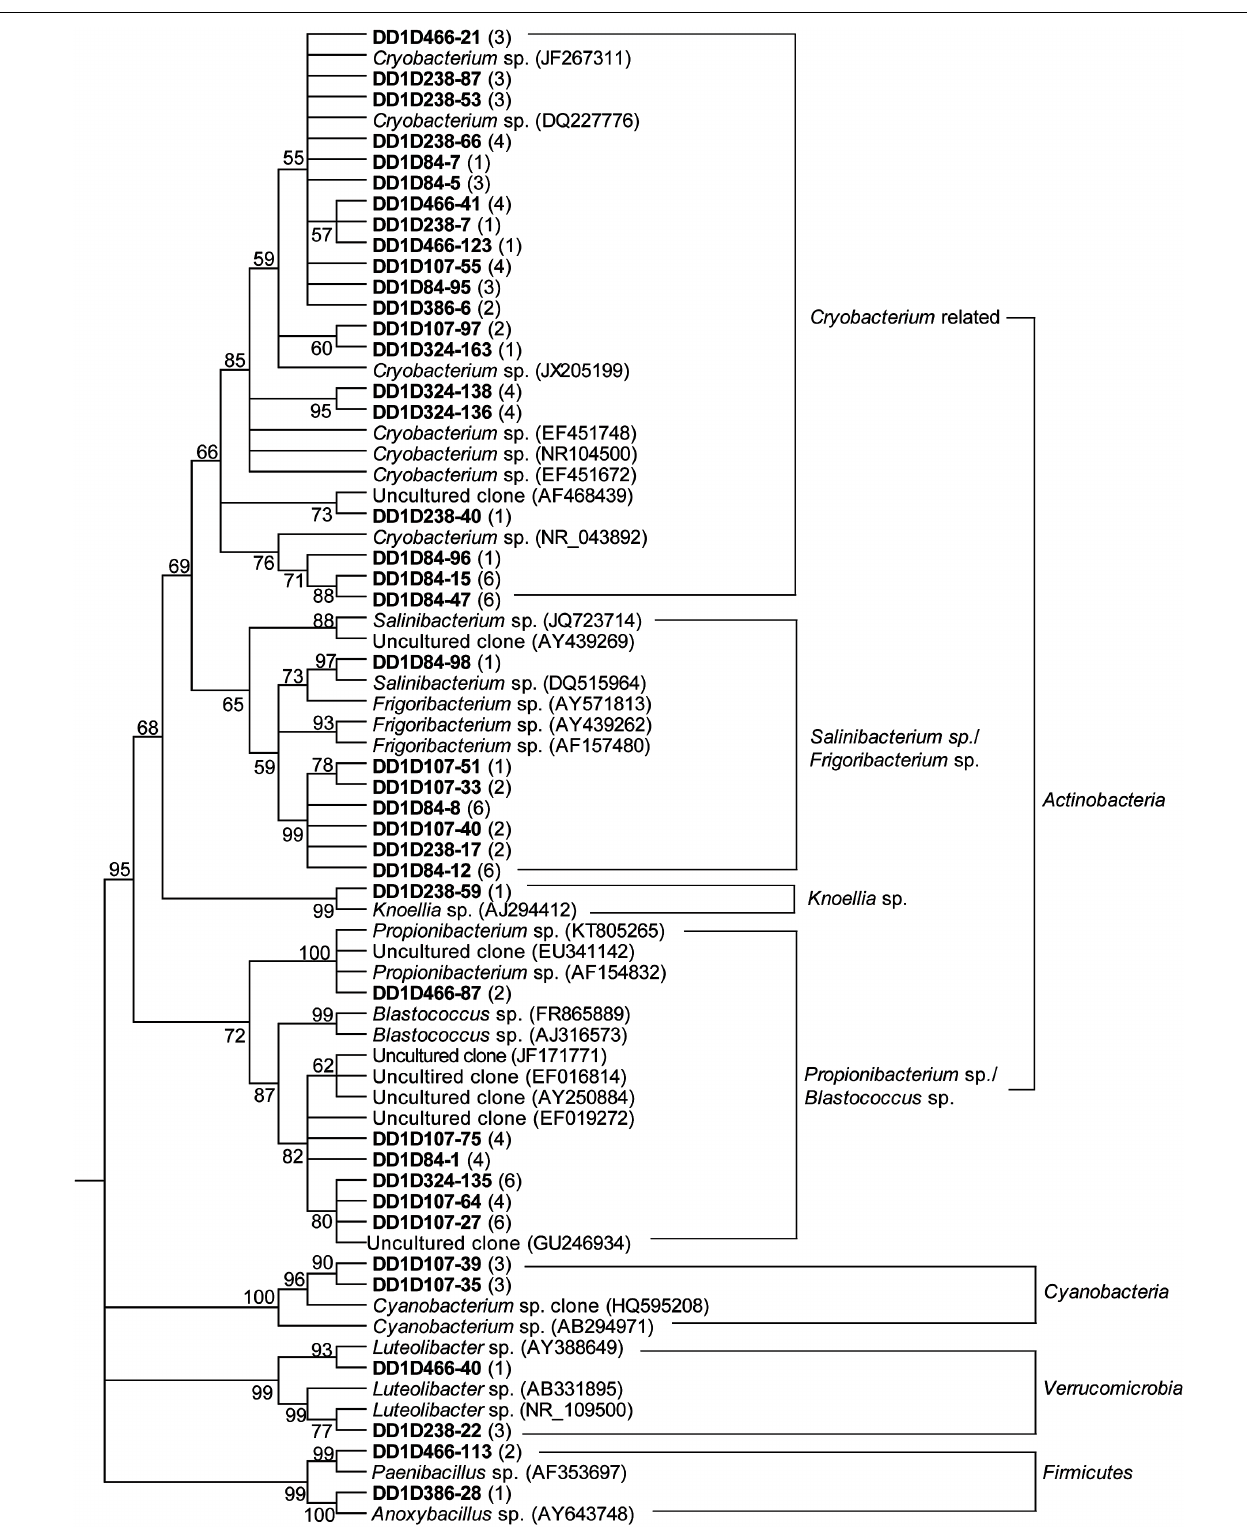
Frontiers in Microbiology |